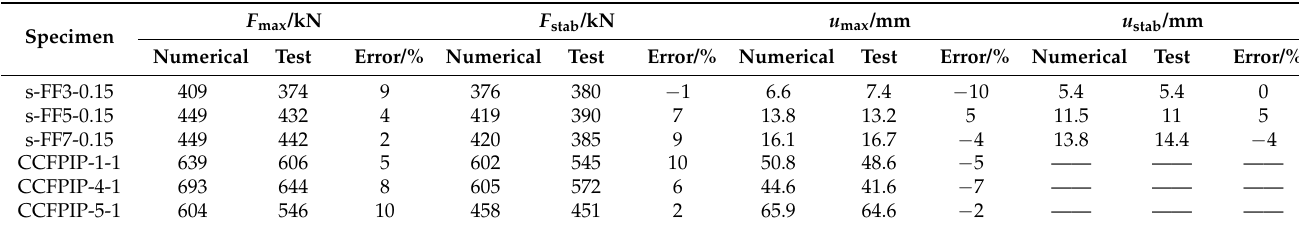
Table 4. Comparison of numerical and test results.